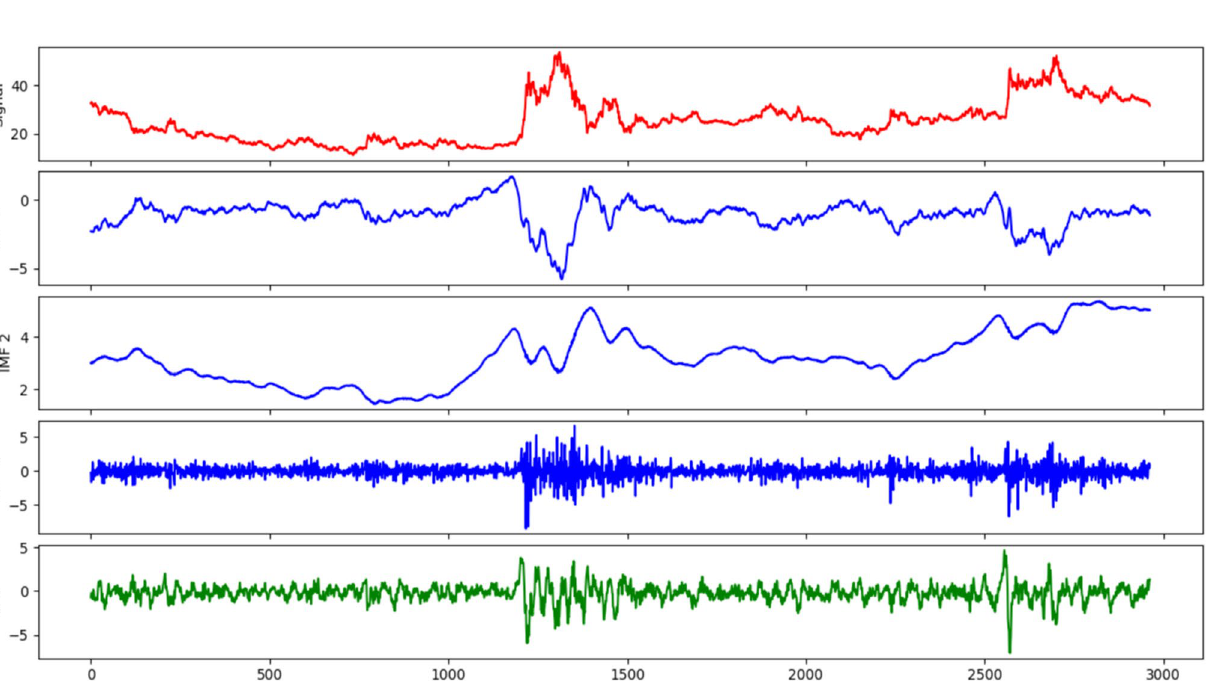
Fig. 10 The results of ICA for the MAE, RMSE, and MAPE of CS-PSO-LSTM at 1-step forecasting are increased by 41.67%, 31.25%, and 36.11% for SH601988, respectively. The results indicate that the CEEMD algorithm optimized by SE is an improved decomposition algorithm. Compared